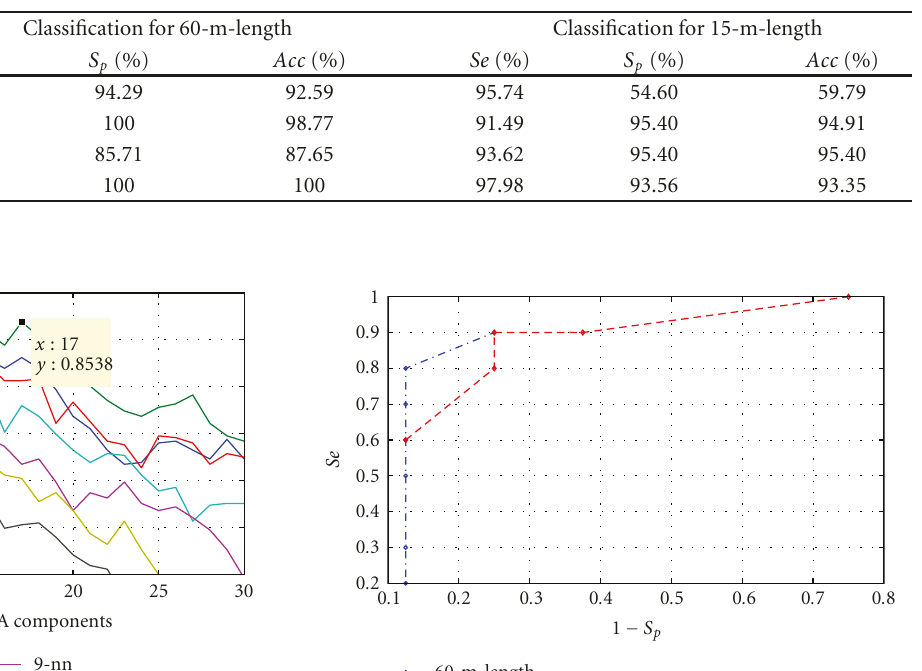
Table 3: Classification of PPG fragments for partially divided set.